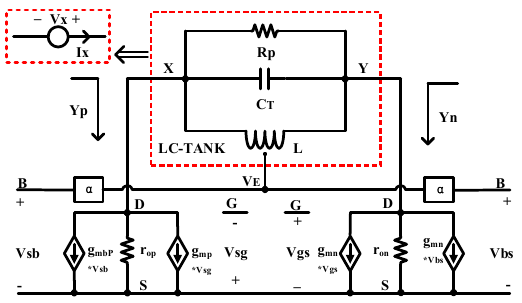
Figure 2. Schematic of the proposed current-reuse VCO.